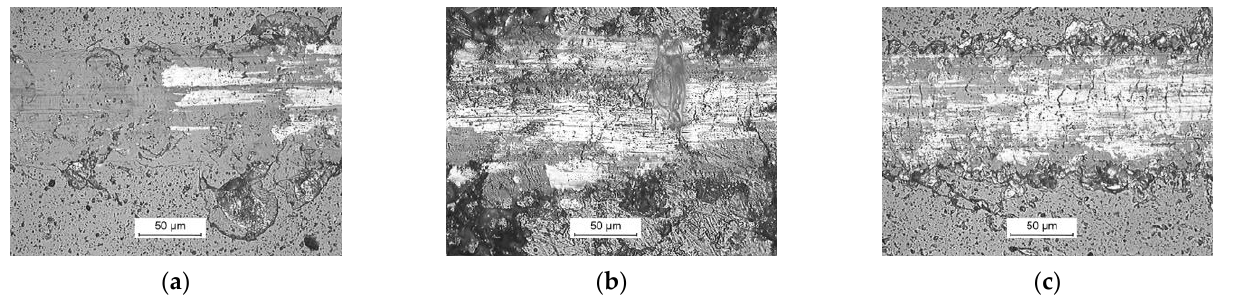
Figure 5. Optical images of the coating failure during the scratch test: ( a ) Group I substrate, sintering temp. 1250 °C, Lc3 (76.4 N); ( b ) Group II substrate, sintering temp. 1050 °C, Lc3 (22.8 N); ( c ) Group III substrate, sintering temp. 1350 °C, Lc3 (69.5 N).